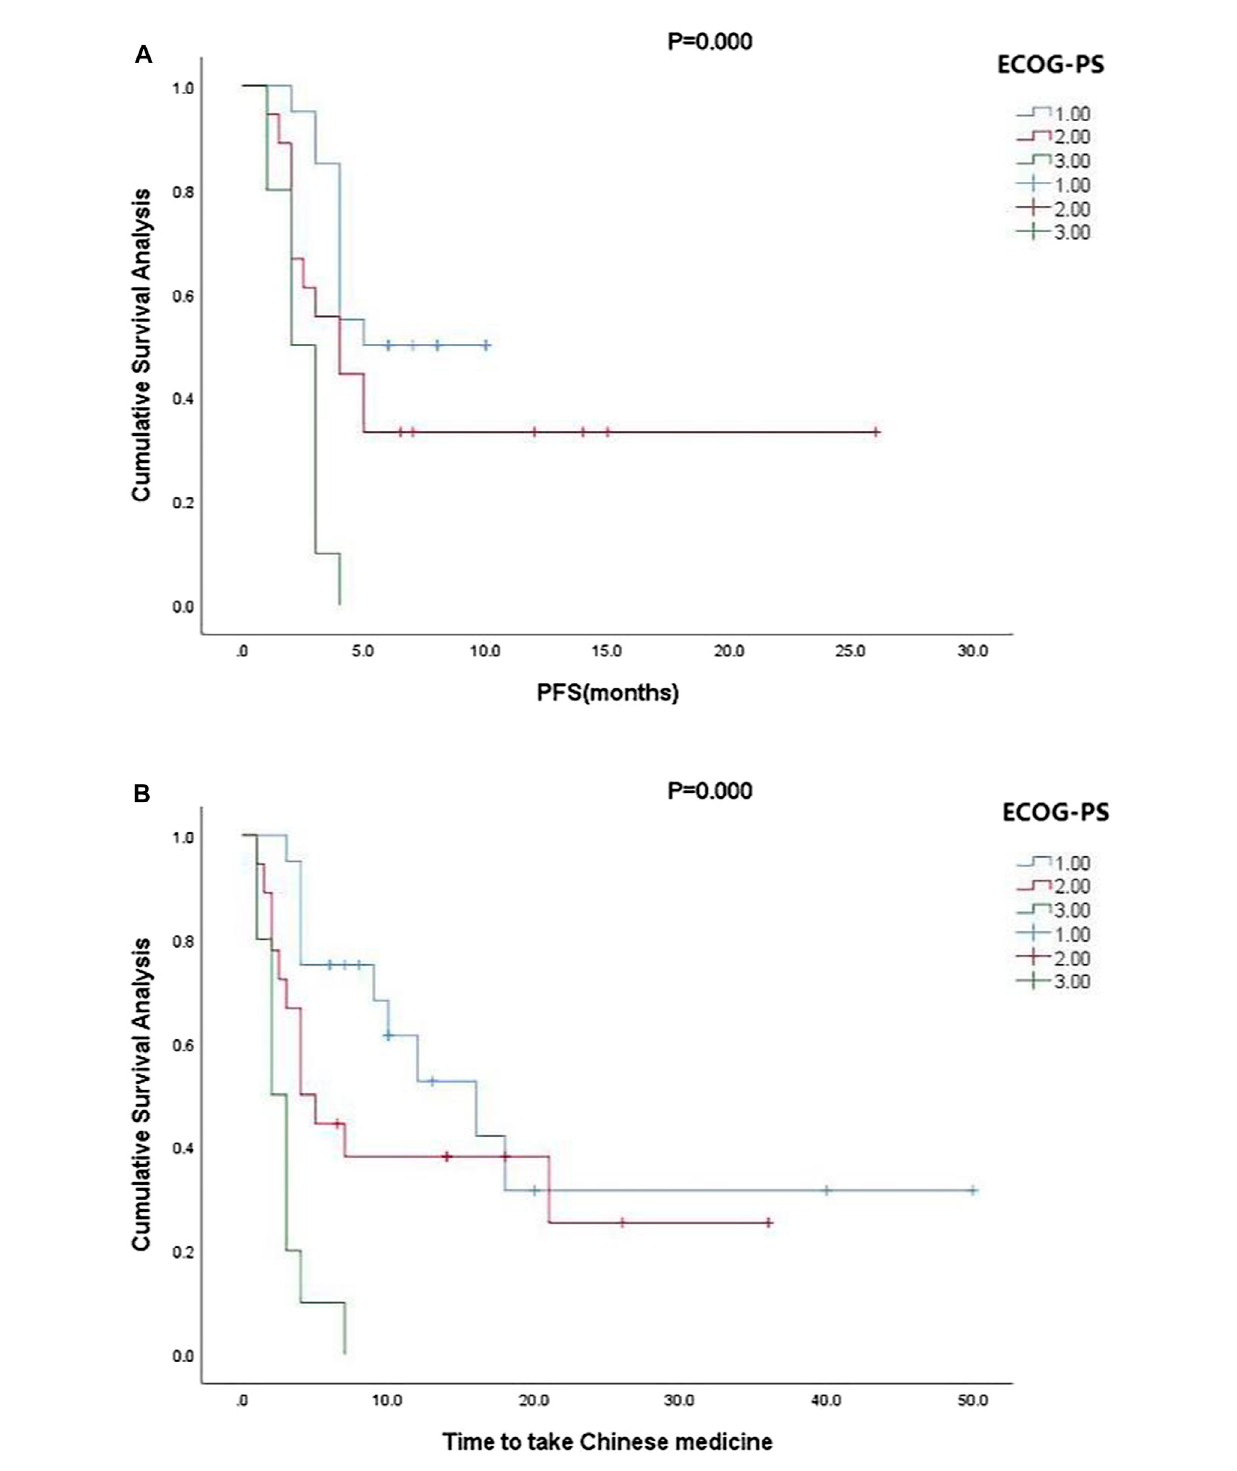
Kaplan-Meier plots showing (A) PFS and (B) TTCM according to ECOG-PS status. ECOG-PS, Eastern Cooperative Oncology Group performance status; PFS, progression-free survival; TTCM, total duration of traditional Chinese